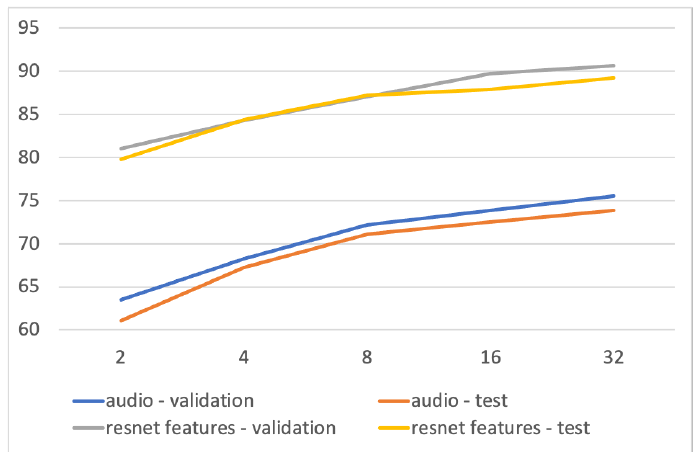
Figure 8. Classification performance with respect to window size (2–32), using the audio model and the ResNet visual features on the validation and test sets. In general, larger windows lead to better